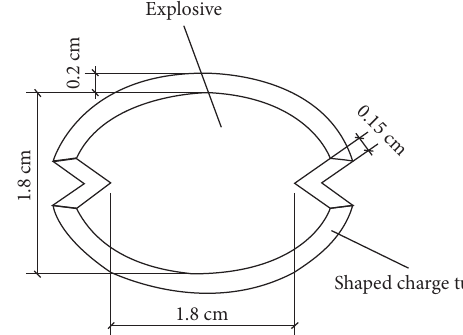
Figure 2: Cross section of the shaped charge tube.